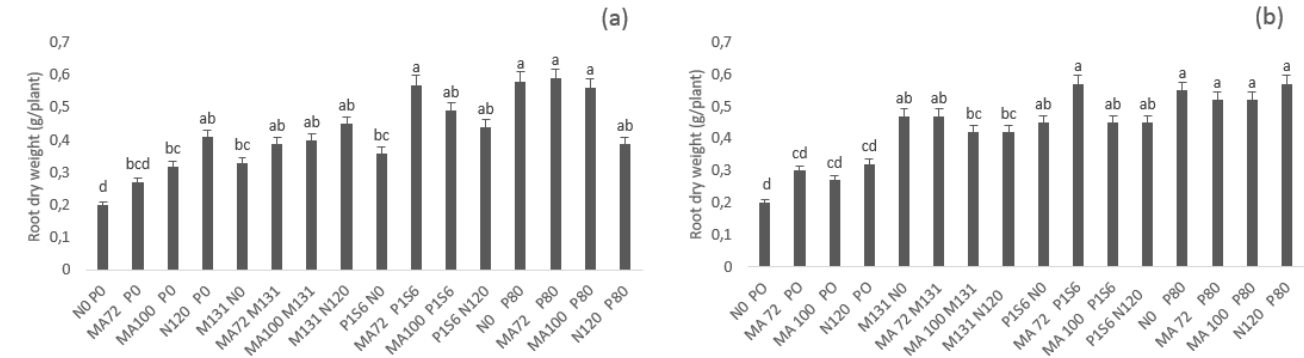
Figure 3. Effect of co-inoculation with Mesorhizobium spp. (MA72 or MA100) and Bacillus sp. (M131) or E. aerogenes (P1S6) and phosphate application combined to rhizobial inoculation on root dry weight of chickpea in Merchouch ( a ) and Ain Sbit ( b ) sites. Bars followed by the same letter are not significantly different at α = 0.05. (P80 indicate application of 80 kg P2O5/ha, N120 indicate application of 120 kg N /ha, N0 and P0 indicate no nitrogen and phosphate chemical fertilizers application). Table 1. Effect of co-inoculation with rhizobia and PSB or phosphate fertilization on the percent of N derived from